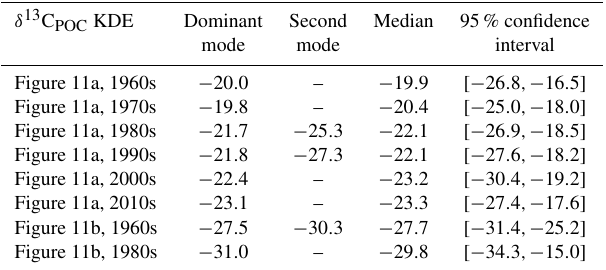
Table A5. Statistical properties of the KDEs derived for Fig. 11 evaluated on an equidistant grid over [− 35 , − 15 ] with 1001 grid points: the first column indicates the respective KDE, the following two its modes, the fourth the median and the fifth the 95% confi- dence interval of the respective KDE. All values are given in per